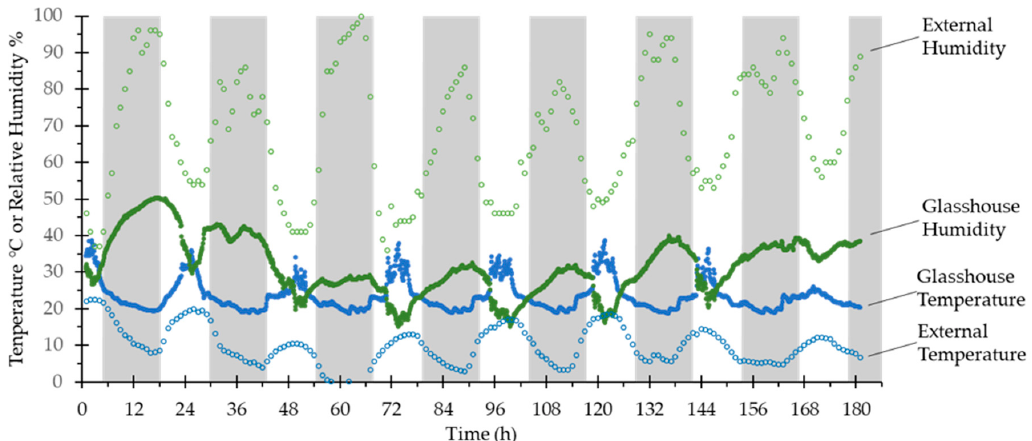
Figure 8. Data recorded by a probe over 182 h in a glasshouse. Green circles are percentage relative humidity, blue circles are temperature (°C). Filled circles are data gathered by the probe in the glasshouse (readings every 5 mins), open circles are from a calibrated weather station approximately 300 m away (readings every 60 mins) for the same period showing external environmental conditions. 0 h was 12 pm on a Saturday afternoon. Dark bars show the period after sunset, light bars the period after sunrise.